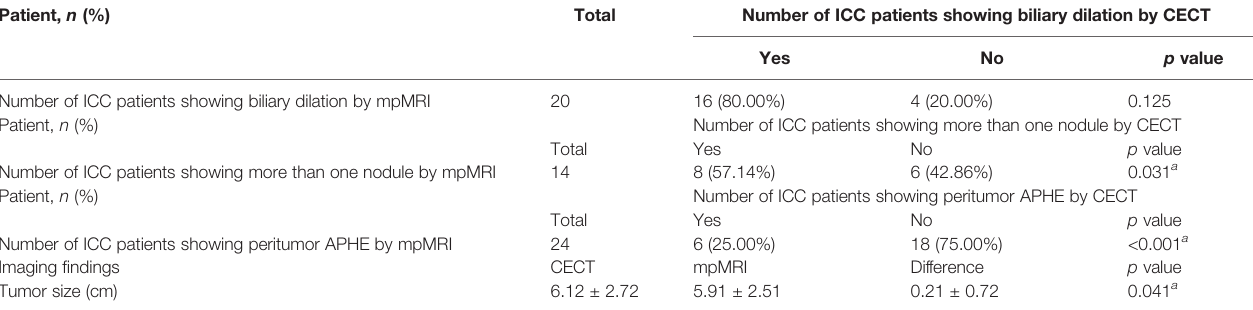
Imaging fi ndings CECT